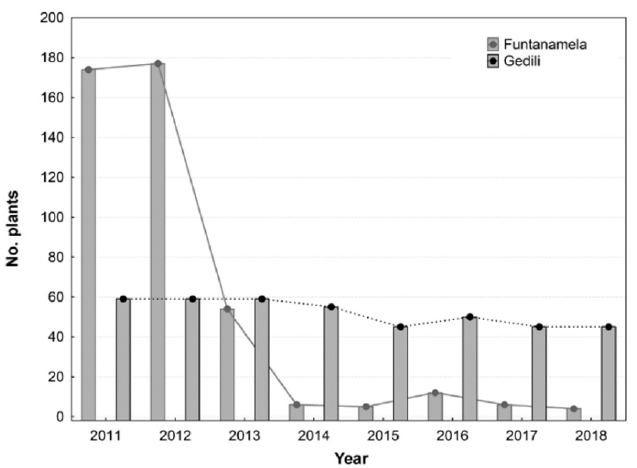
Figure 3 . Population size per year in Funtanamela (Laconi) and Gedili (Jerzu) during the 8-year period of monitoring.